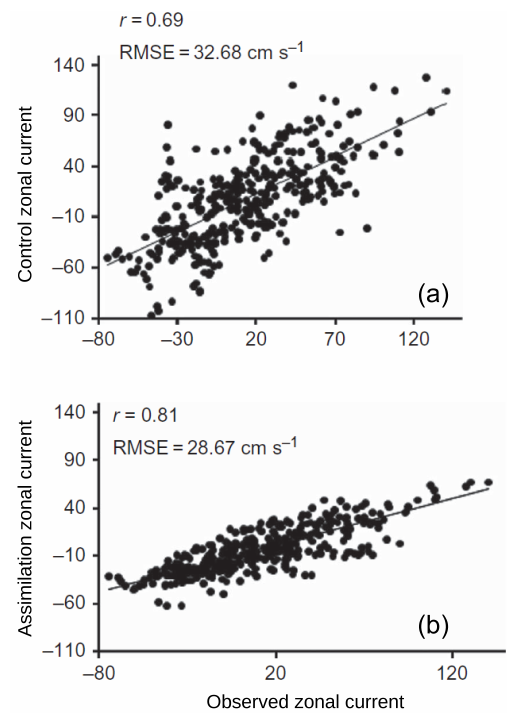
Figure 9. Correspondence between the zonal velocity component measured at the RAMA station located at 1.5 ◦ N, 90.0 ◦ E. (a) Model without assimilation. (b) Resulting from assimilating OSCAR cur- rents. From Fig. 1 in Santoki et al.